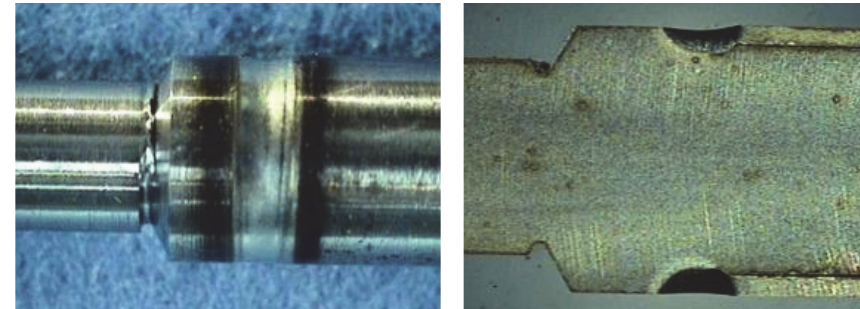
Figure 14: Weld bead shape welded at 35 A-30 rpm.